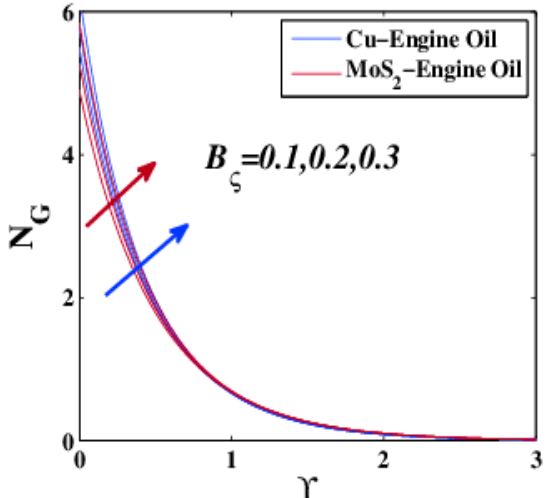
Figure 20. Entropy generation variation N G under the influence of B ς